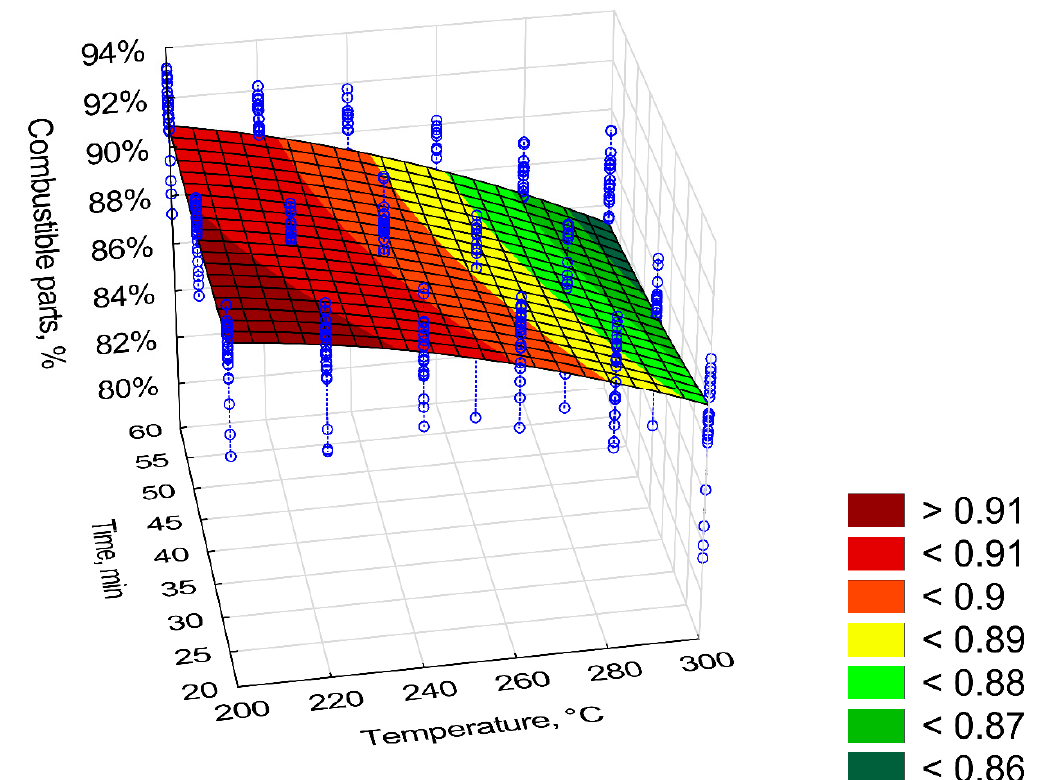
Figure 7. Visualization of 3D model of the combustible part ( CP ) of torrefied pruned biomass. Table 5. Statistical evaluation of the combustible part ( CP ) model of torrefied pruned biomass.